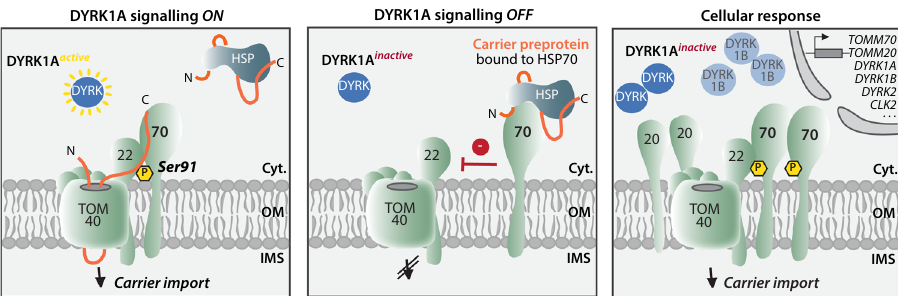
Fig. 6 Schematic model depicting the role of DYRK1A kinase as critical activator of the carrier import pathway in human mitochondria. DYRK1A- mediated phosphorylation of TOM70 Ser91 stimulates docking of the precursor bound import receptor to the central translocation pore to enable import of carrier proteins. Upon inhibition, DYRK1A fails to phosphorylate TOM70 Ser91 and protein import is impaired. A protective response secures the carrier import pathway by upregulation of TOM70 and further import receptors as well as backup kinases which can also phosphorylate TOM70 Ser91 to compensate for the lack of